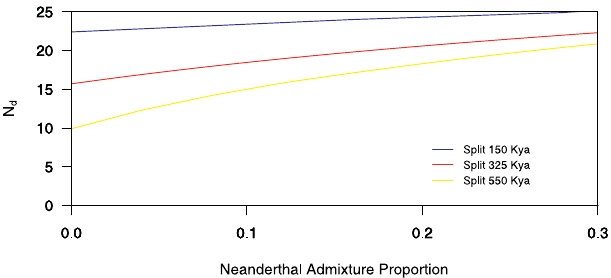
Figure 3. Estimates of N d as a Function of the Neanderthal Admixture Proportion and the Modern European–Neanderthal Population Split